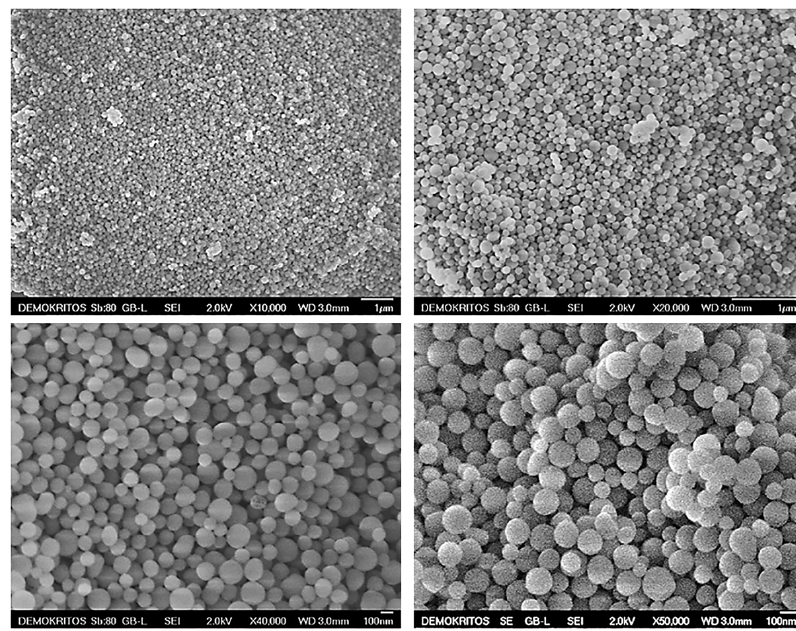
Figure 3. SEM micrographs of the produced MCM-48 particles.